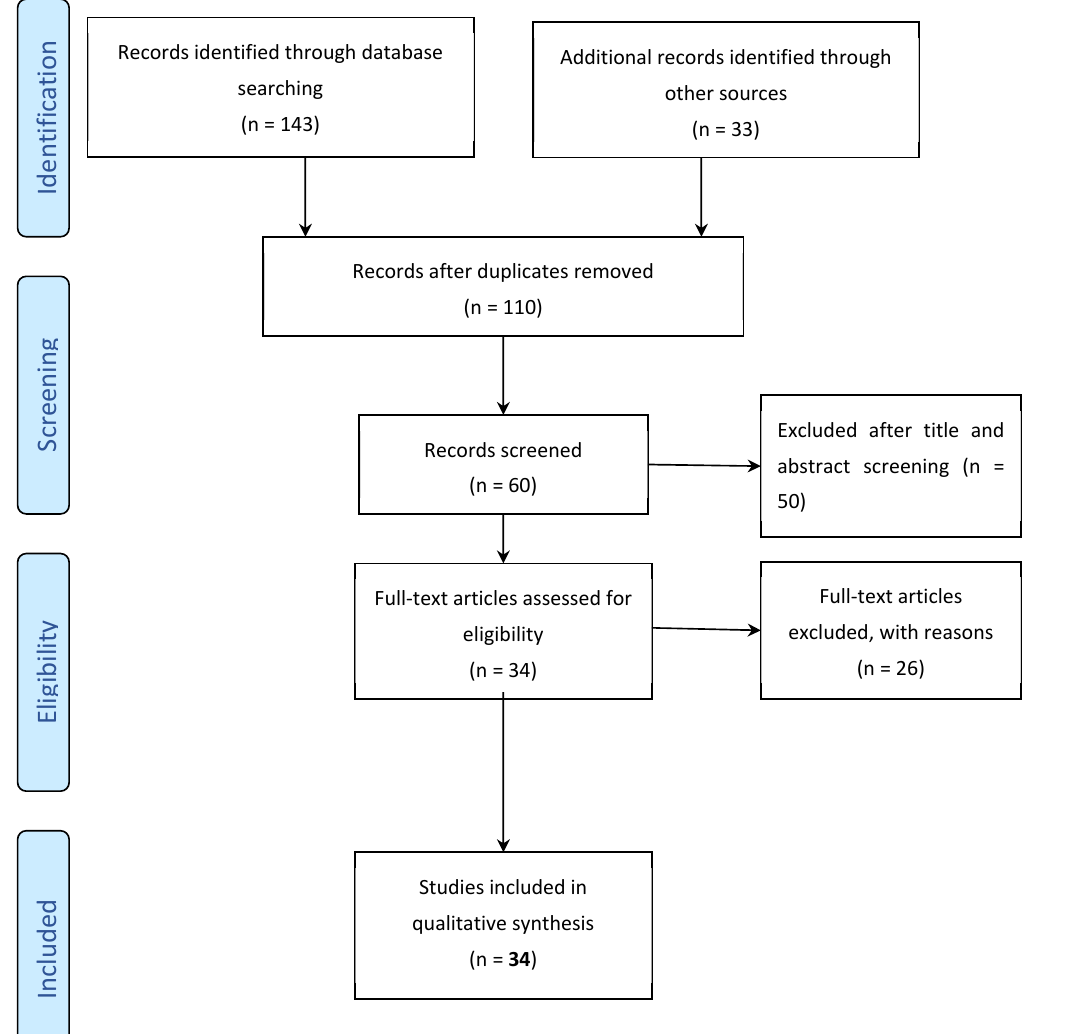
Figure 1. PRISMA flowchart showing the search method.